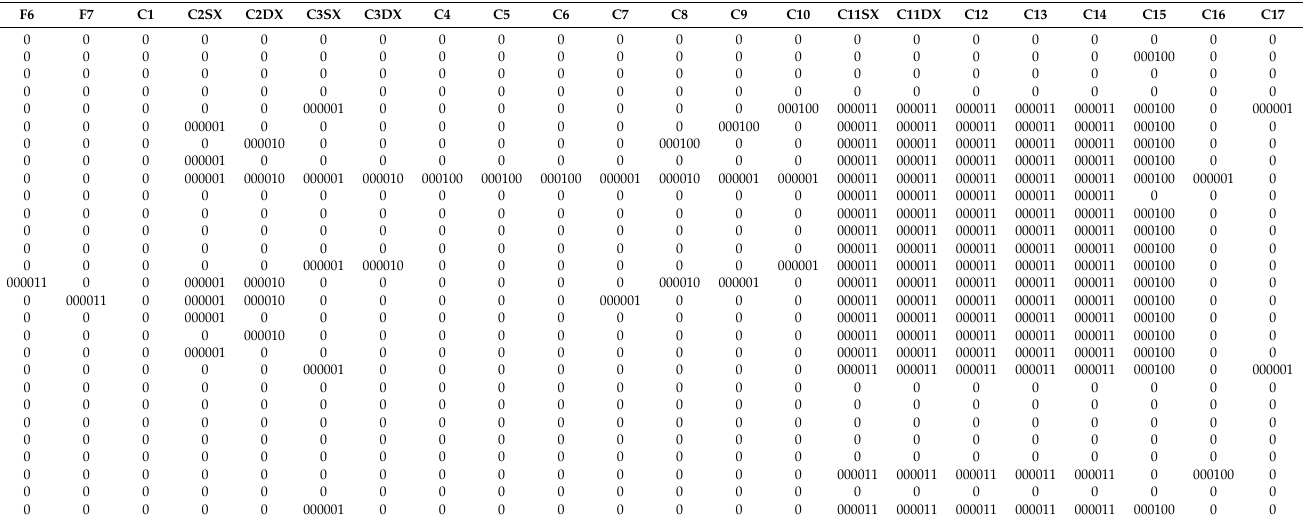
Table 5. Disassembly precedence matrix